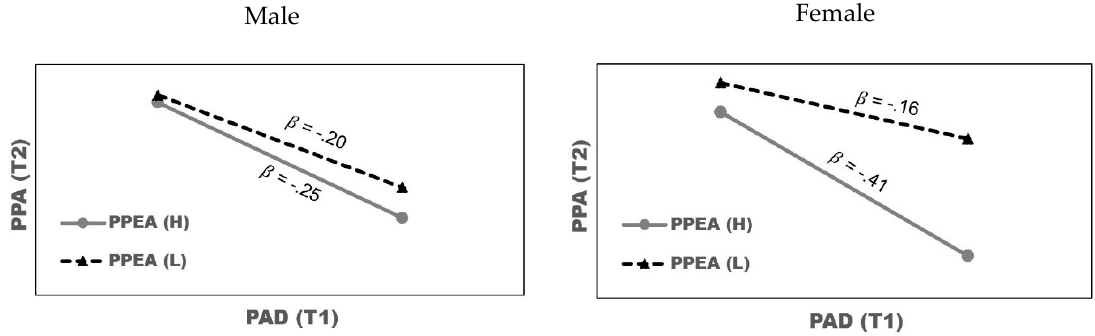
Figure 1 . The effect of Perceived Aggressive Disposition (PAD) on Perceived Peer Acceptance (PPA) by gender and participation in physical education activities. Note: PPEA = perceived physical education activity; PAD = perceived aggressive disposition; PPA = perceived peer acceptance; H = high; L = low. In Model 3, which is during the non-transition phase, the slope of c (DPPEA) × e (PAD (T1)) was statistically significant ( β = 0.40, t = 2.10, p = 0.036). DPPEA was divided into a high group